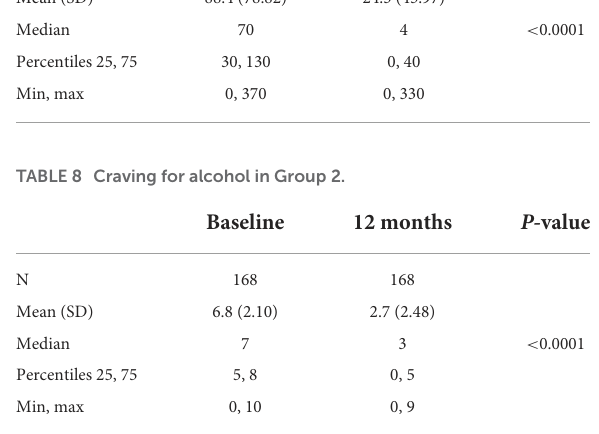
TABLE 5B Percentage of subjects with null or low-risk alcohol consumption for the maximum recorded dose.